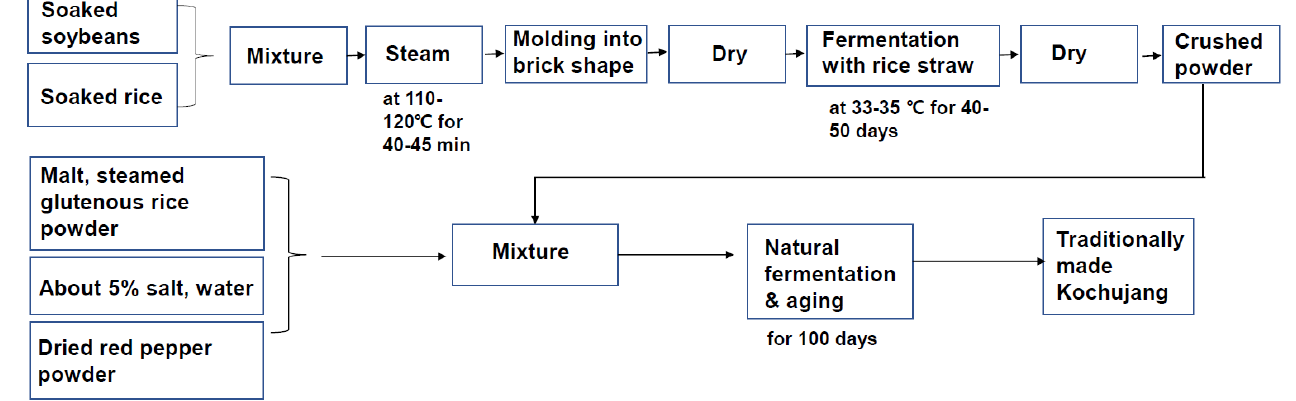
Figure 2. Schematic representation of the traditional process for Kochujang preparation.